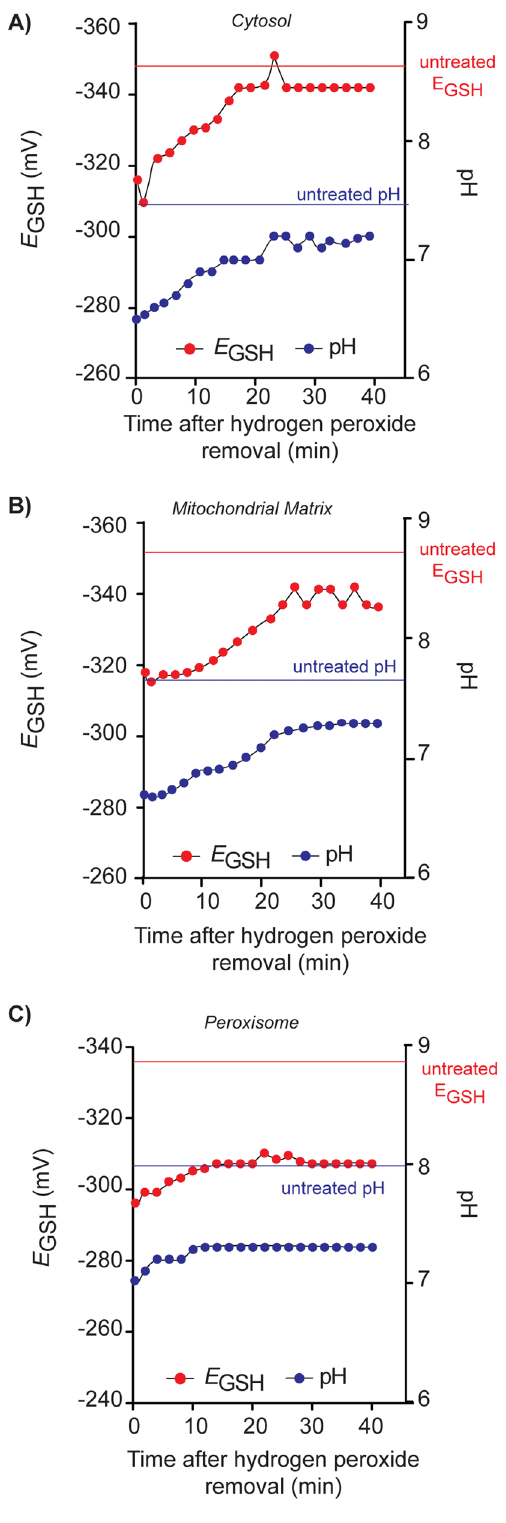
Figure 5. Dynamic recovery of cells after hydrogen peroxide treatment. Cells were pregrown in SC URA (48 h; 30 u C; 600 rpm), inoculated in SC URA (A 600 =0.001) and grown (25 u C; 600 rpm) until exponential phase (A 600 = , 0.5). Starting E GSH was measured then cells were treated with hydrogen peroxide (2 mM; 20 min; 25 u C), washed and resuspended in fresh medium, and pH and redox state analyzed by flow cytometry at two-minute intervals. A) cytosolic pH and E GSH ,